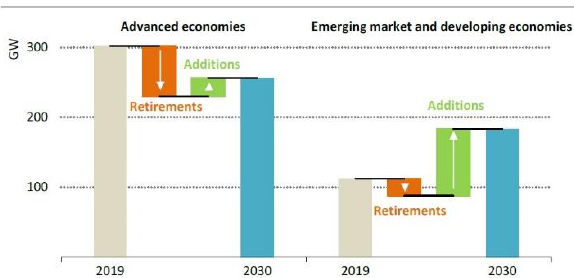
Figure 1. Nuclear power installed capacity, capacity